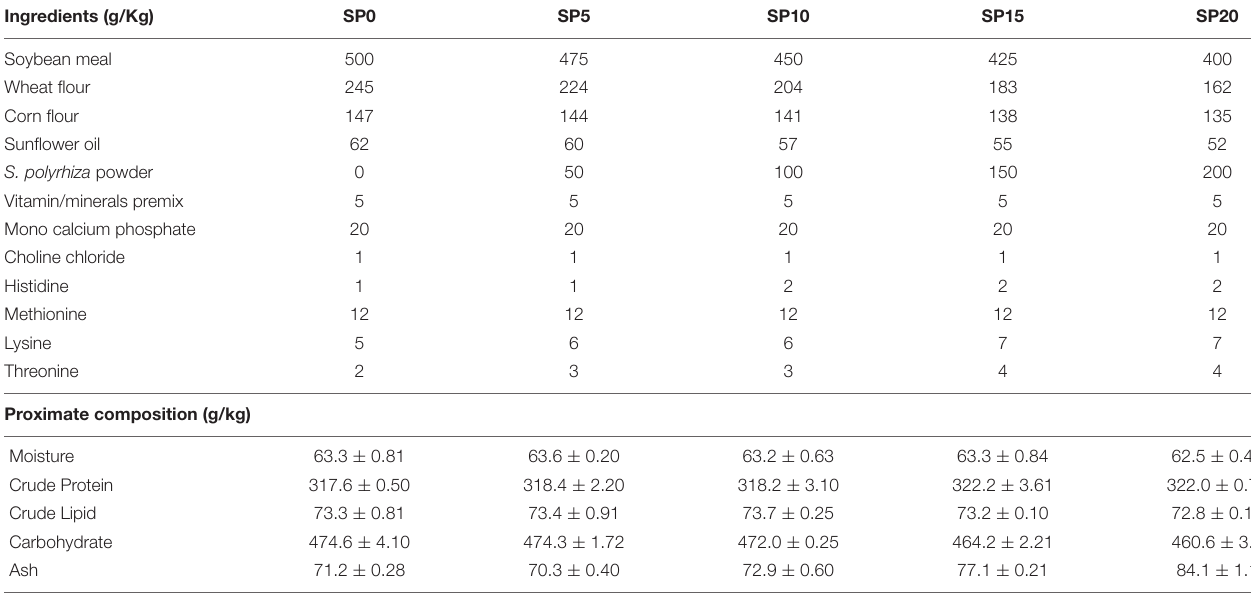
TABLE 1 | Formulations and measured proximate compositions of experimental diets.